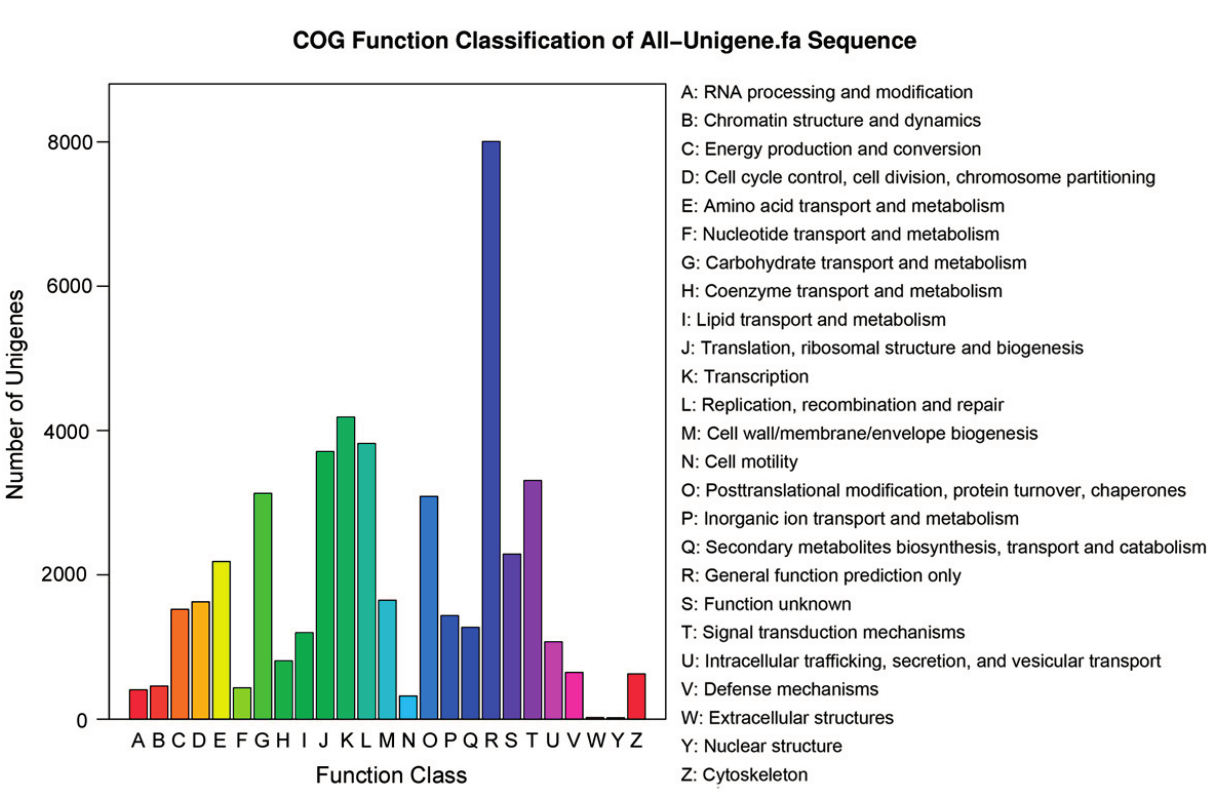
Figure 6. Clusters of orthologous groups (COG) functional classification. A total of 24,872 unigenes were assigned to 25 classifications. The capital letters along the x -axis indicate the COG categories as listed on the right of the histogram, and the y -axis indicates the number of